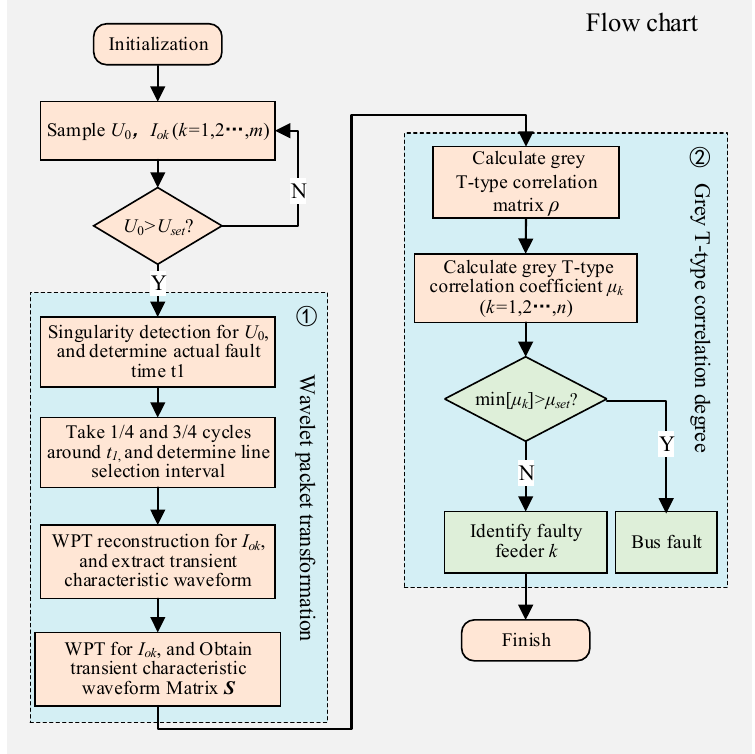
Figure 6. The flow chart of the proposed